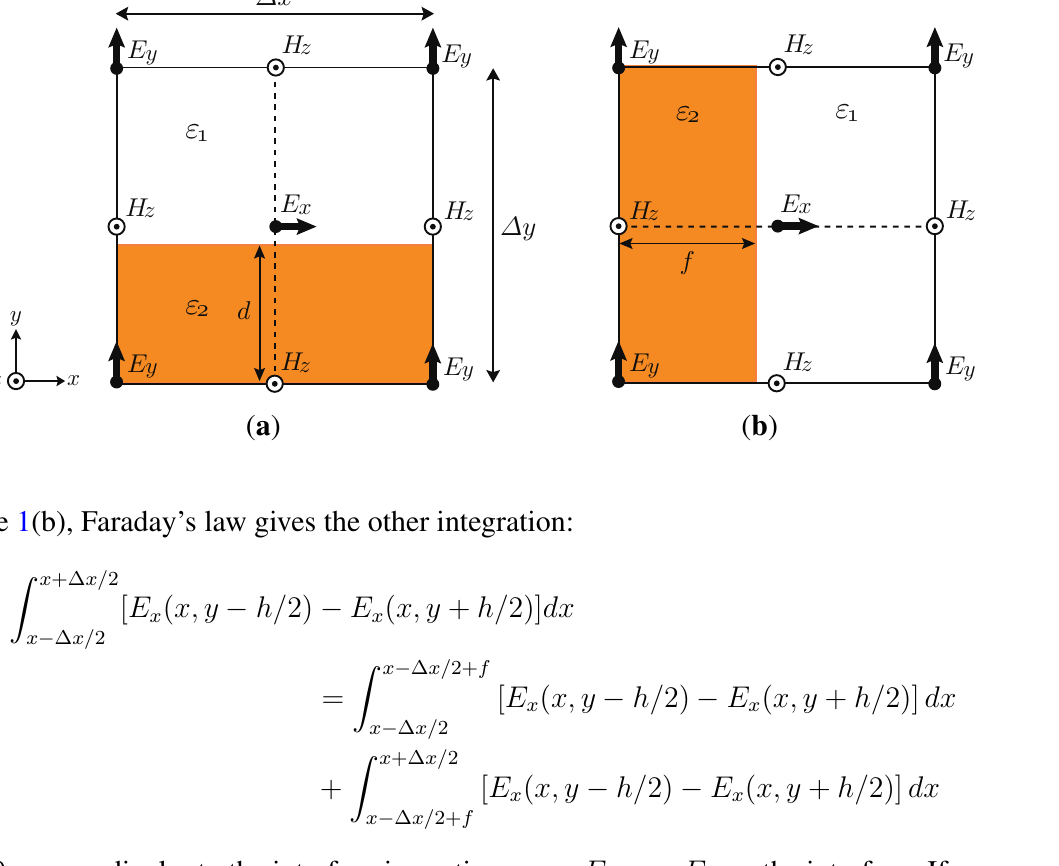
Figure 1. Partially filled FDTD cells in the TM mode: ( a ) interface parallel to E ( b ) interface perpendicular to E and Faraday’s laws. d; f represent filling factors on the integration lines. "